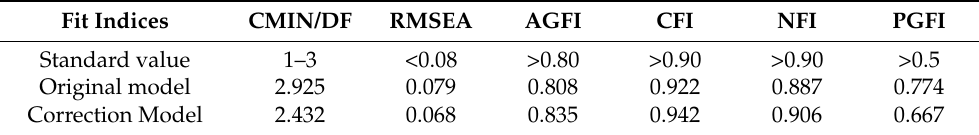
Table 4. Test results of goodness-of-fit indices for SEM.